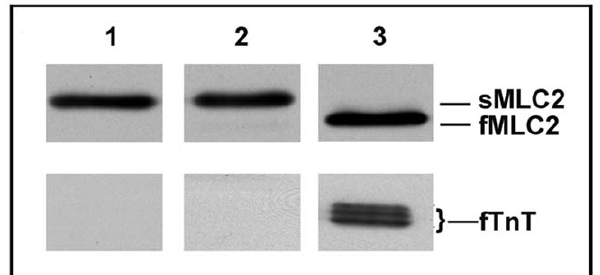
Figure 6. Western blot analysis of regulatory protein expres- sion in slow and fast fibers (B) corresponds to western blot characterization of slow and fast isoforms of MLC2 (above) or TnT (below) for slow fiber isolated from untreated soleus (1), for slow fiber isolated from PUGNAc-treated soleus (2) or fast fiber isolated from epitroclearis muscle (3).